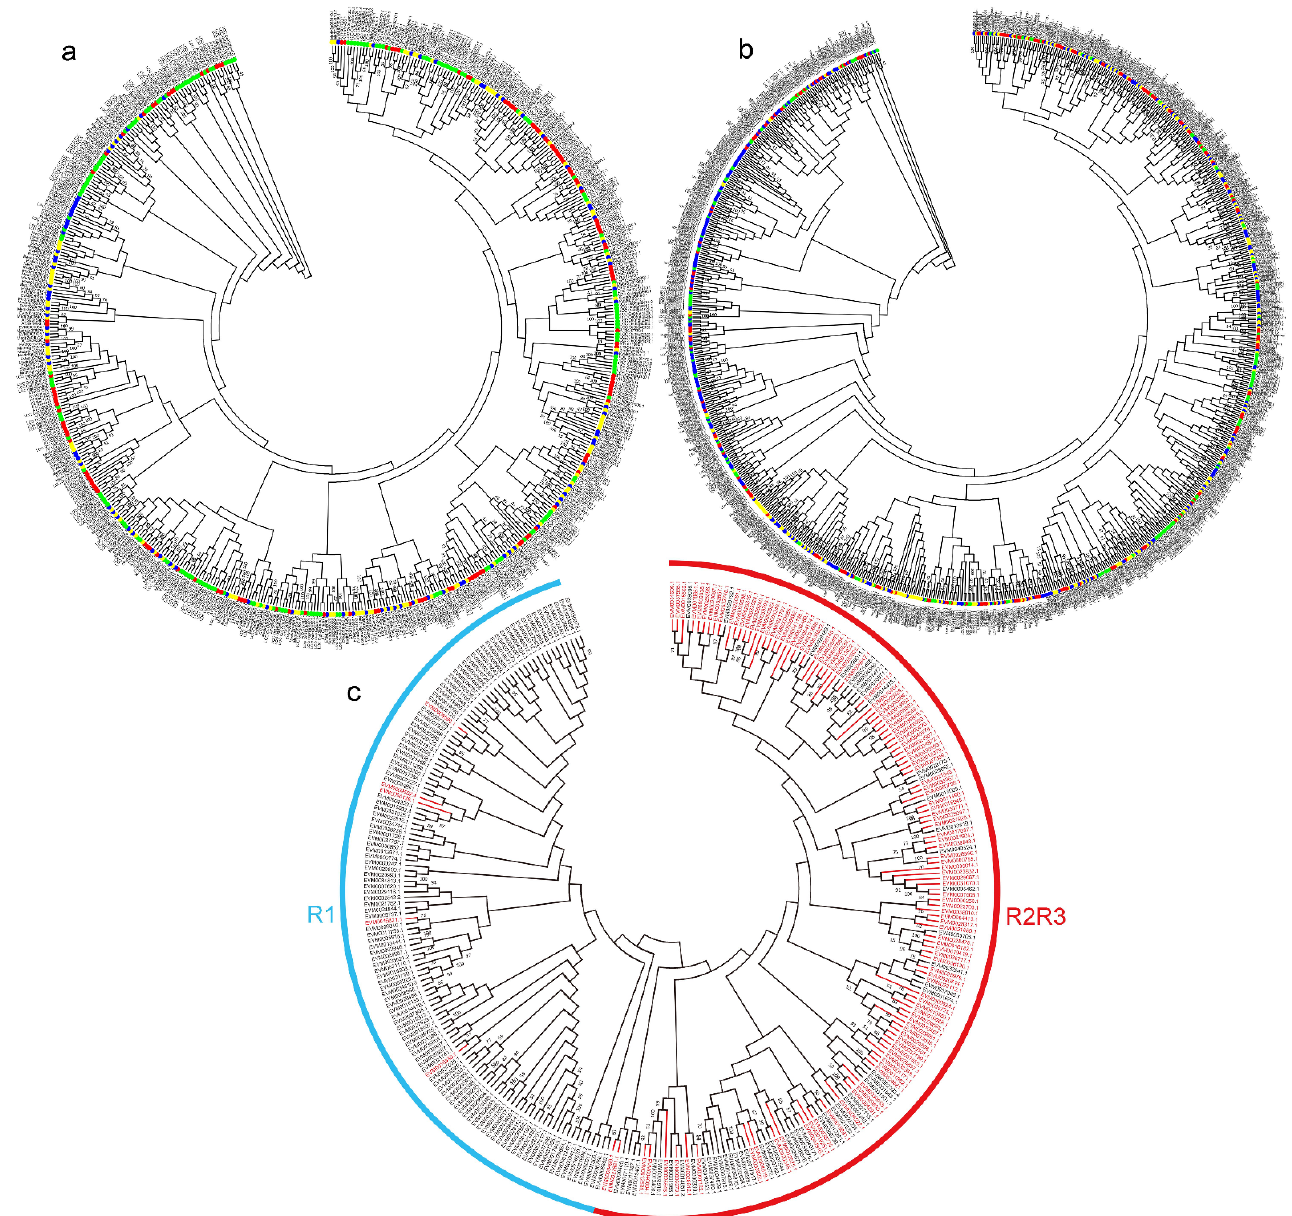
Figure 3. Phylogenetic analysis of NAC and MYB members. ( a ) Phylogenetic relationships of NAC proteins from M. albus , M. truncatula , Arabidopsis and rice. ( b ) Phylogenetic relationships of MYB proteins from M. albus , M. truncatula , Arabidopsis and rice. ( c ) Phylogenetic relationships of MaMYB proteins. The genes with the R2R3 domain are marked in red. All trees were constructed via MEGA 7.0 with the neighbor-joining (NJ) method (bootstrap, 1000 replicates).